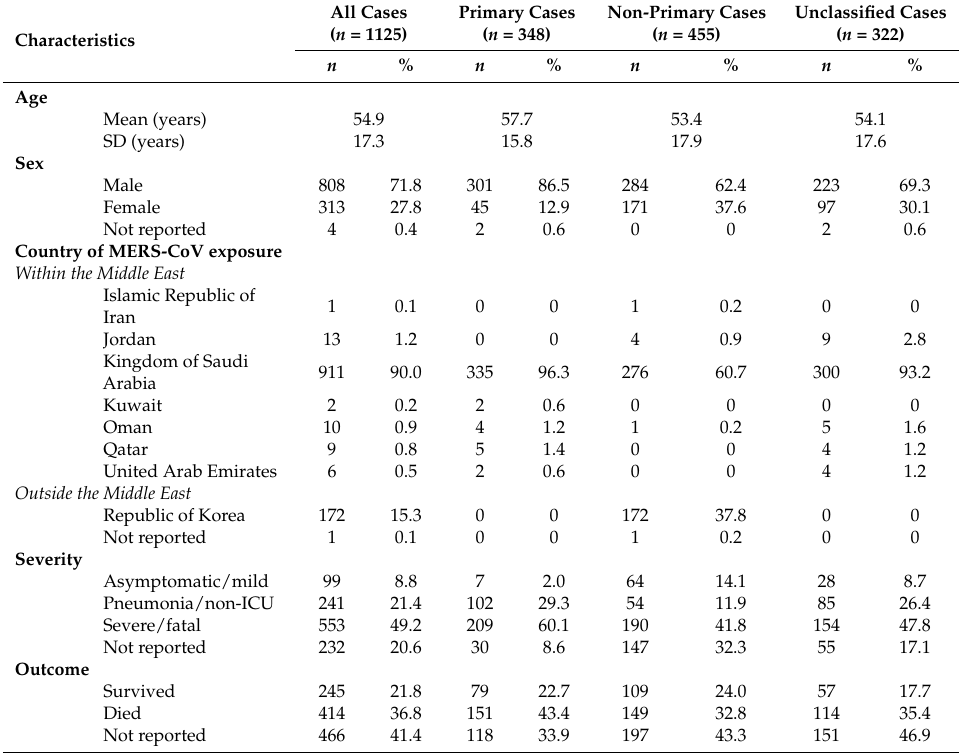
Table 1. Description of laboratory-confirmed MERS-CoV cases reported to World Health Organization (WHO) between 1 January 2015 and 13 April 2018 ( n = 1125). Results are presented as frequencies (%), unless otherwise